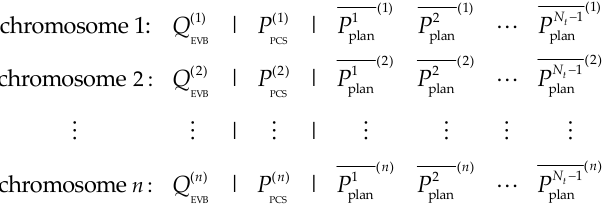
Figure 4. Segmented coding of the chromosome.